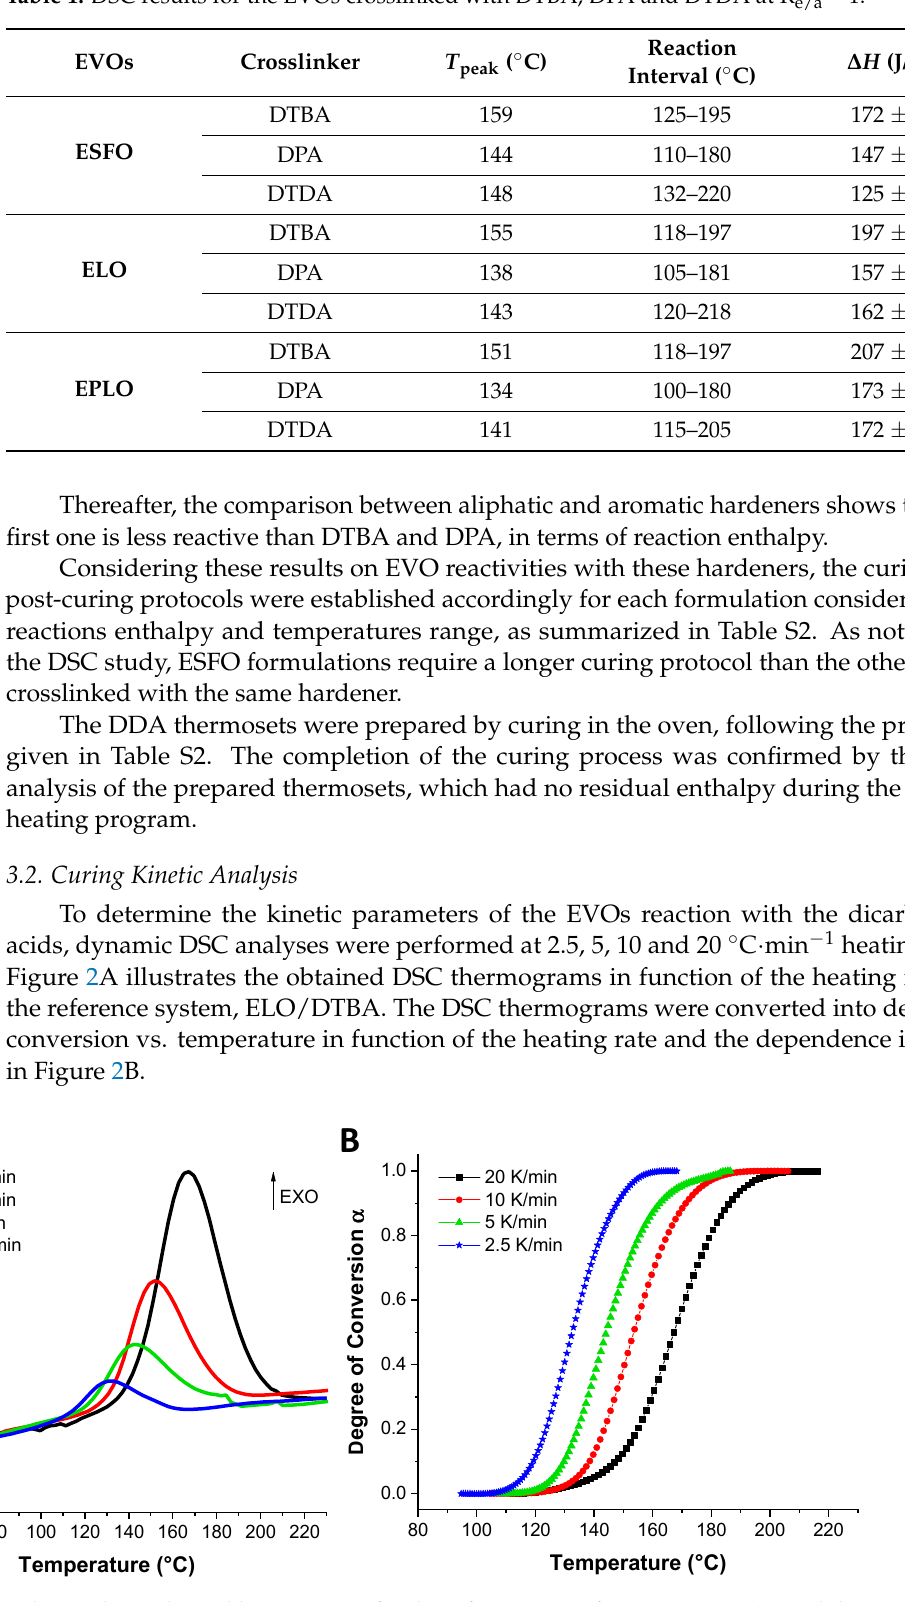
Figure 2. DSC thermograms obtained at indicated heating rates for the reference ELO/DTBA system ( A ) and degrees of conversion dependence with temperature ( B ).